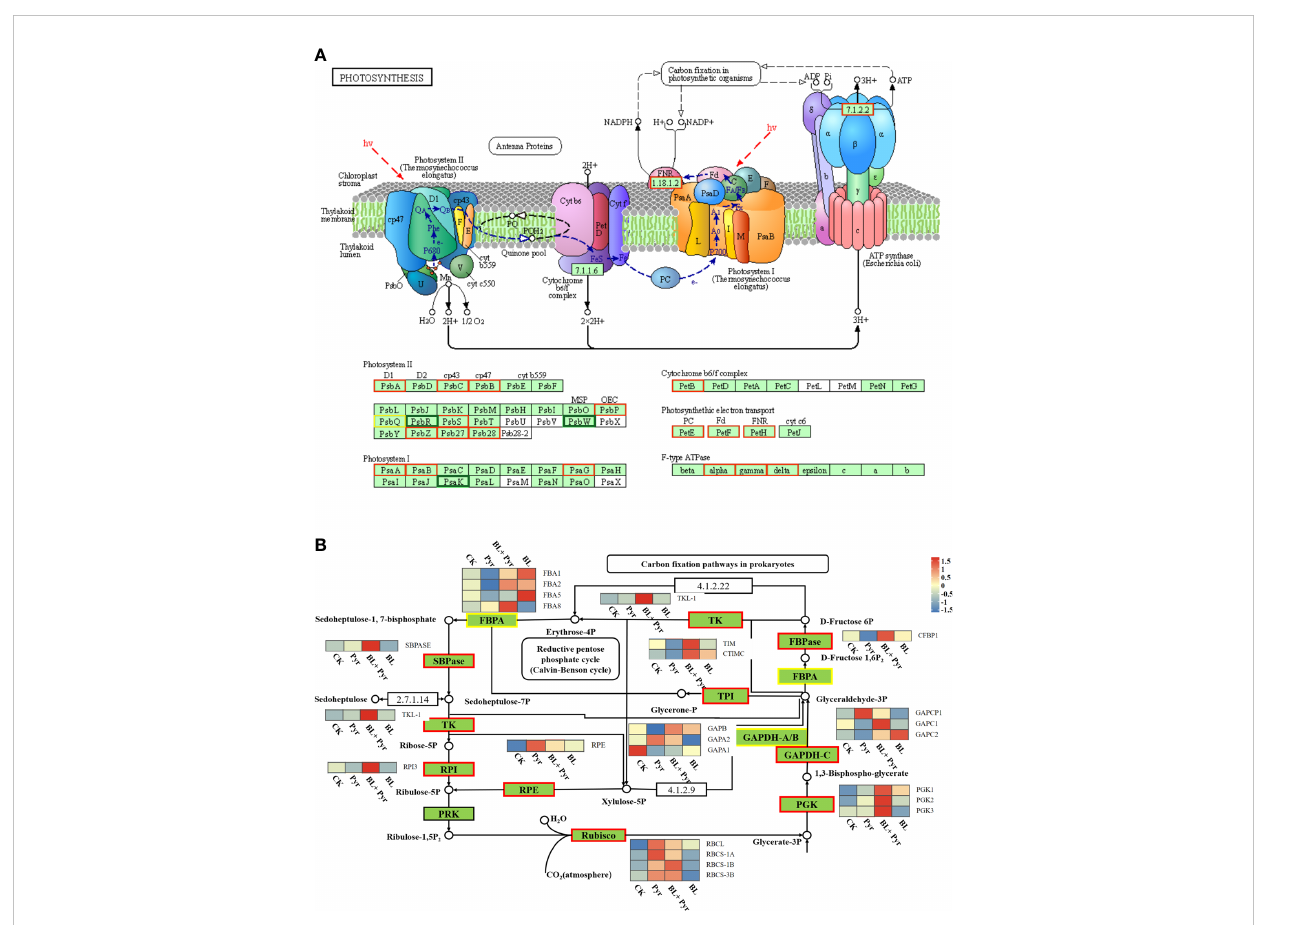
FIGURE 7 BL+Pyr treatment activated transcription of genes in photosynthesis and carbon fi xation pathway. (A) Photosynthesis pathway tagged with DEGs of BL+Pyr-treated group versus untreated group; (B) Carbon fi xation pathway tagged with DEGs of BL+Pyr-treated group versus untreated group. The heat map close to the enzyme showed the expression level of the gene encoding the corresponding enzyme. The different colored boxes on the protein names indicate that the gene encoding the protein is either up- or down-regulated by the BL+Pyr-treated group versus the untreated group. CK, untreated; Pyr, Treated with 3 m M pyraclostrobin; BL+Pyr, Treated with 1 m M BL in combinations with 3 m M pyraclostrobin; BL, Treated with 1 m M BL. SBPase, Sedoheptulose-1,7-bisphosphatase; FBPA, Fructose-1,6-bisphosphate aldolase; FBPase, Fructose-1,6-bisphosphatases; TK, Transketolase; RPE, Ribulose-phosphate 3-epimerase; TPI, Triosephosphate isomerase; GAPDH, Glyceraldehyde 3-phosphate dehydrogenase; PGK, Phosphoglycerate kinase; RPI, Ribose 5-phosphate isomerase A; PRK,